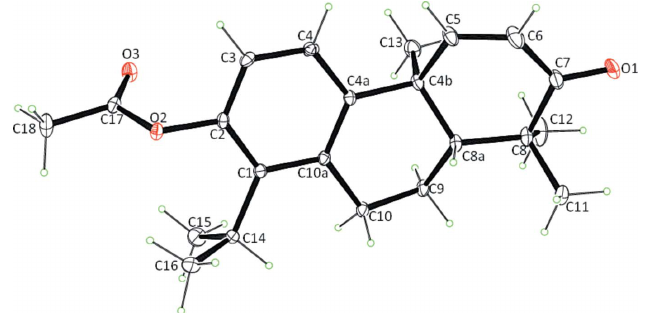
Figure 2 The molecular structure of the title compound with the atom-numbering scheme. The displacement ellipsoids are drawn at the 30% probability level. Only the major disorder components are shown.